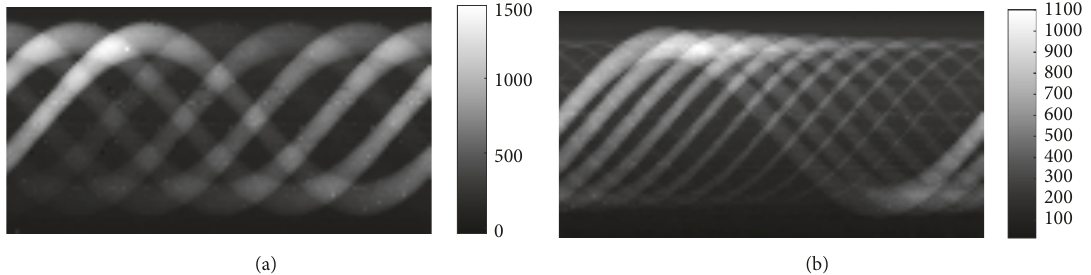
Figure 7: The reconstructed sinograms of (a) phantom 𝐴 and (b) phantom 𝐵 .